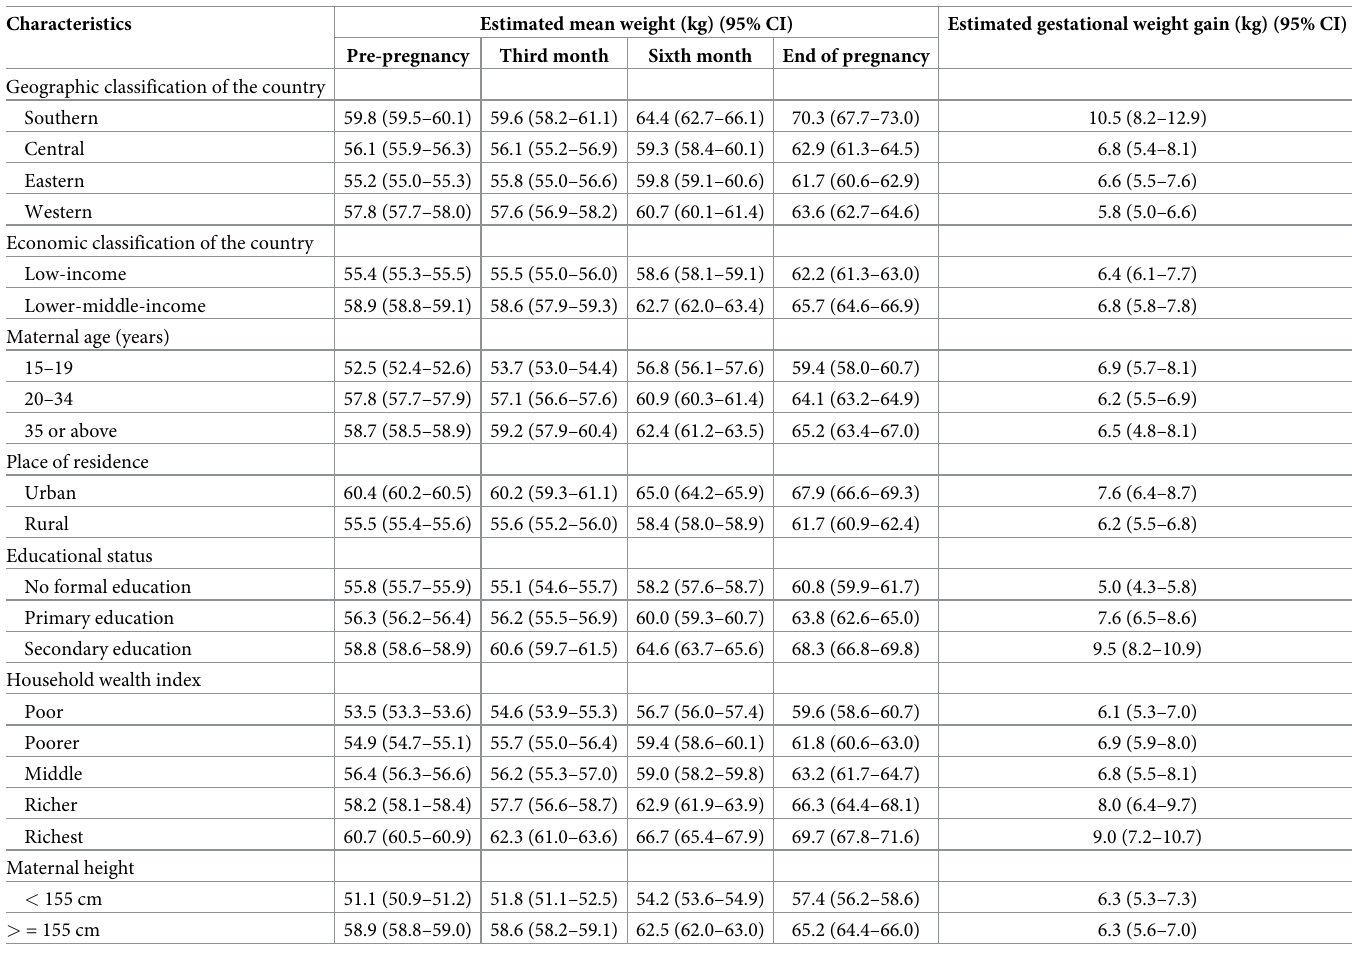
Table 3. Gestational weight gain by household and maternal characteristics, sub-Saharan Africa, 2010–2018.